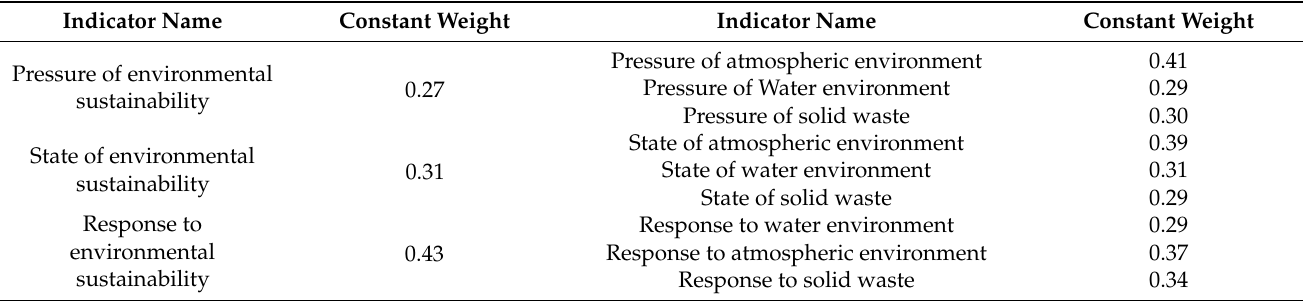
Table 3. Constant